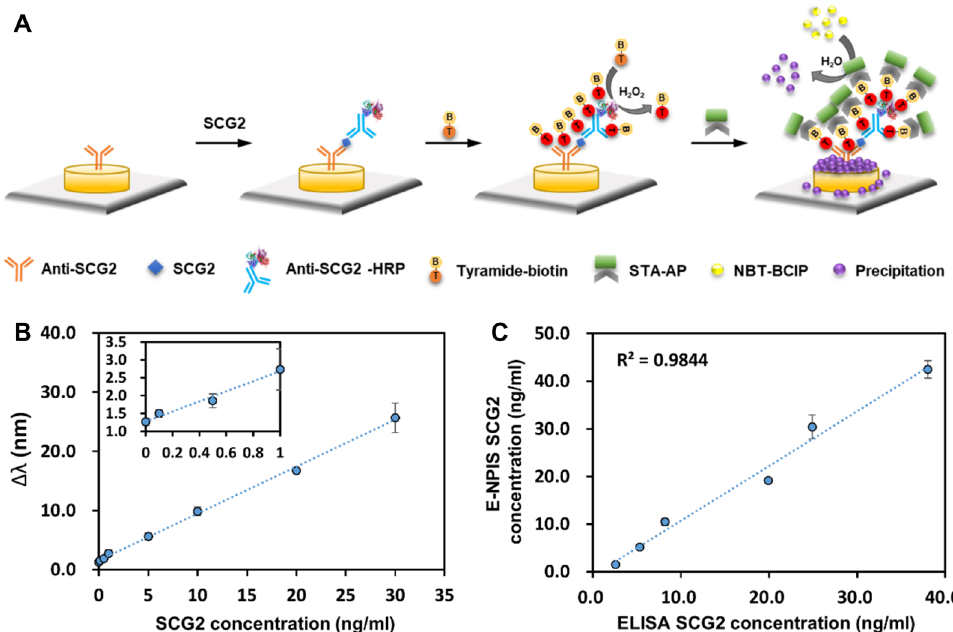
Figure 2. Enhanced nanoplasmonic immunosensor based on tyramide amplification strategy. ( A ) Schematic illustration of the enhanced nanoplasmonic immunosensor using enzyme precipitation reaction combined